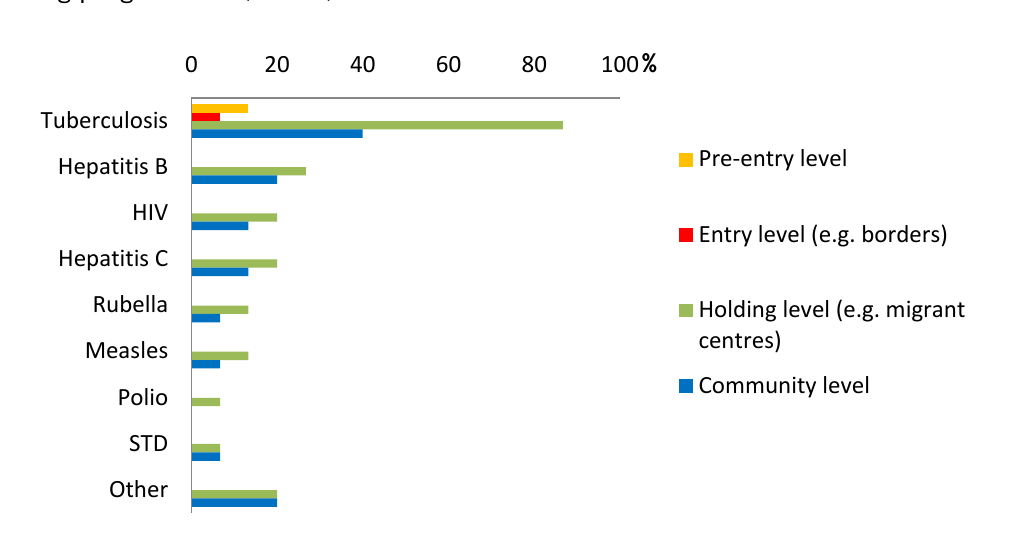
Figure 2. The level for screening for each infectious disease in countries with implemented screening programmes ( n =